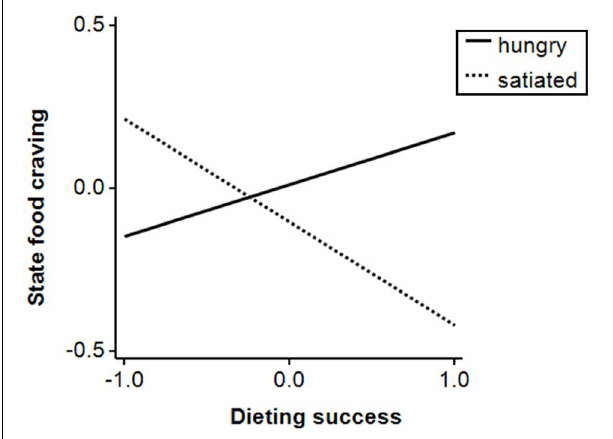
FIGURE 5 | State food craving (scores on the Food Cravings Questionnaire—State after the task minus scores before the task) as a function of group and dieting success in study 2. All variables are z